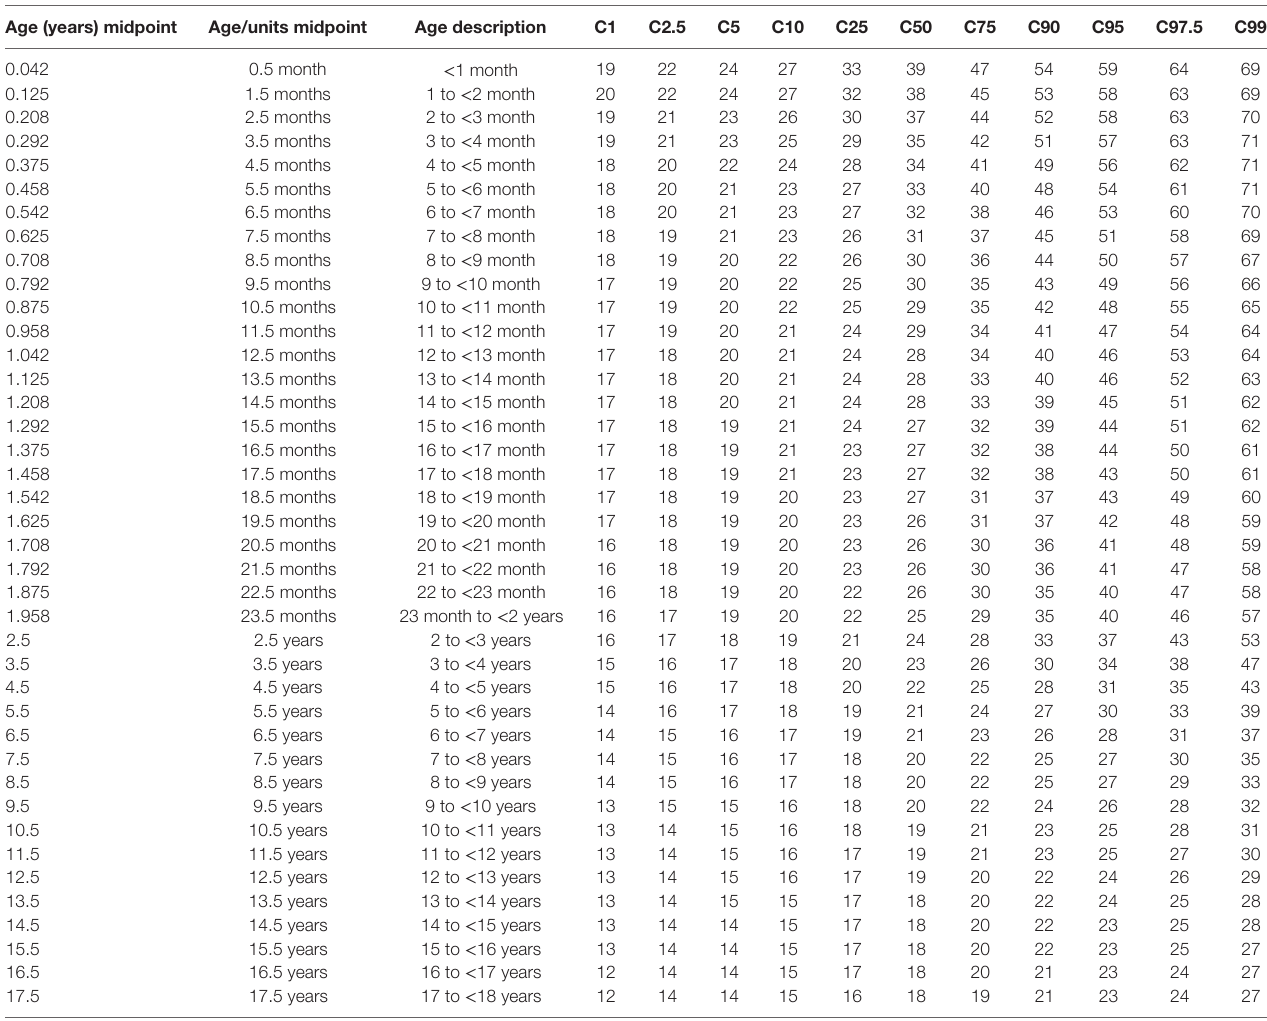
TaBle 5 | Respiratory rate (RR, breaths/minute) centiles a by